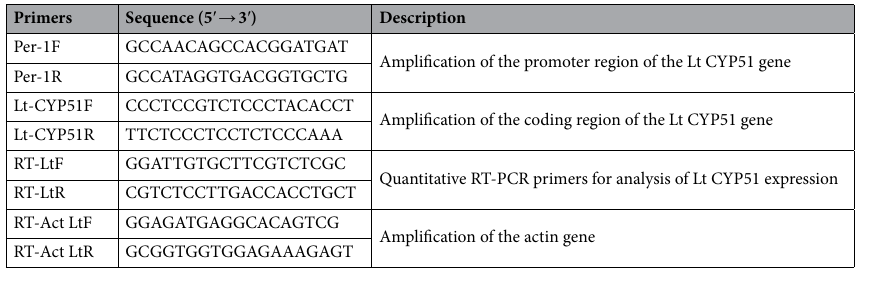
Table 1. Primers utilized in this